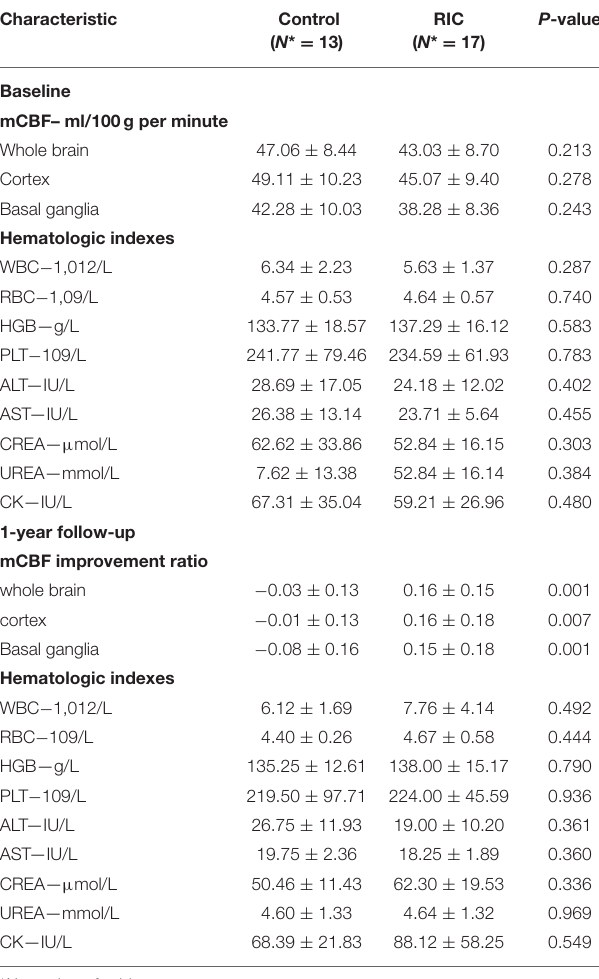
[four to M2 and one to anterior cerebral artery (ACA)]; three progressed from proximal to distal M1 segment; one progressed from stenotic lesion to occlusive lesion at M1 segment and one progressed from ACA A1 to A2 segment. In the RIC group, three hemispheres suffered progression from segment M1 to other segments (two to M2, one to ACA) and one progressed from proximal to distal M1 segment. The improvement of CBF and stenotic-occlusive lesion of two subjects were shown in Figure 3 . No significant difference was documented in MRA score at baseline and 1-year follow-up between the two groups ( Table 3